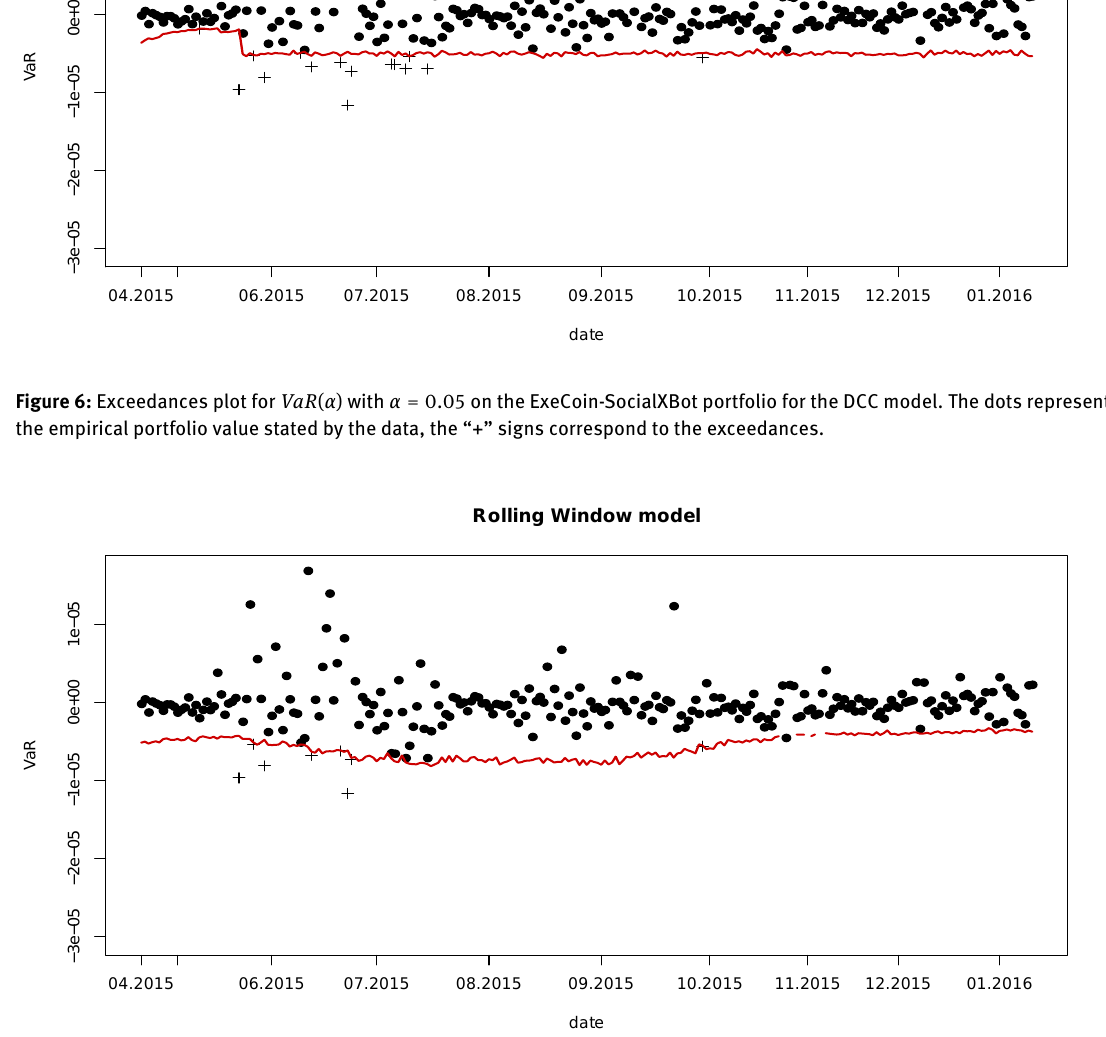
models, it is nevertheless important as only the previous day’s information is required. The proposed Lévy model is simple in its construction as it uses only a simple jump process.